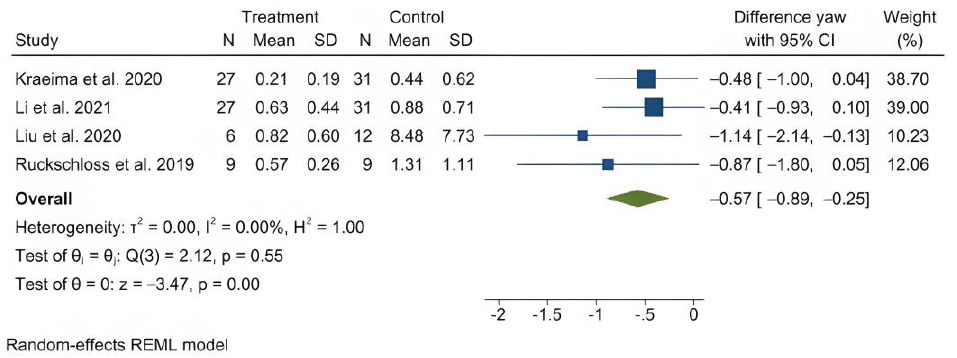
Figure 14. Forest plot showing differences in yaw deviation between PSI and control (conventional osteosynthesis and CAD/CAM splint or wafer).